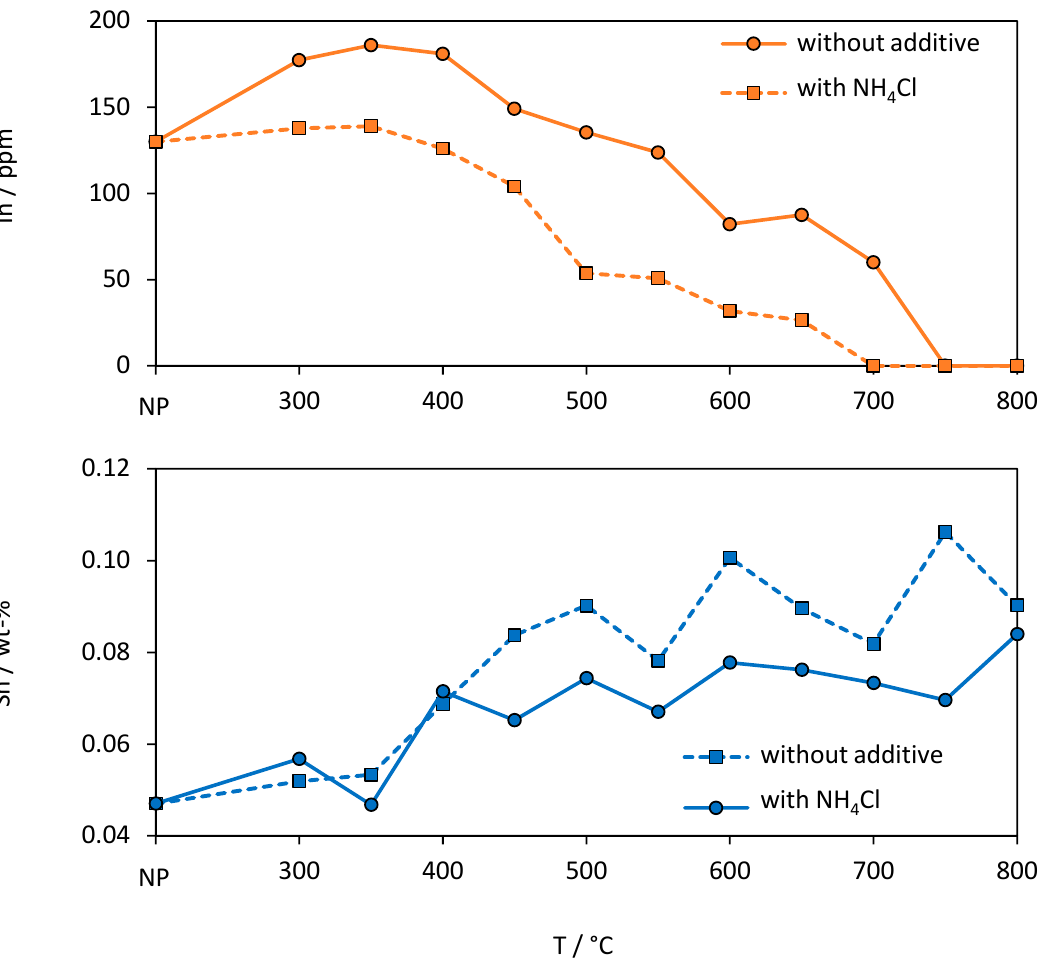
Figure 4. Concentration of In and Sn in the solid residue at different pyrolysis temperatures.